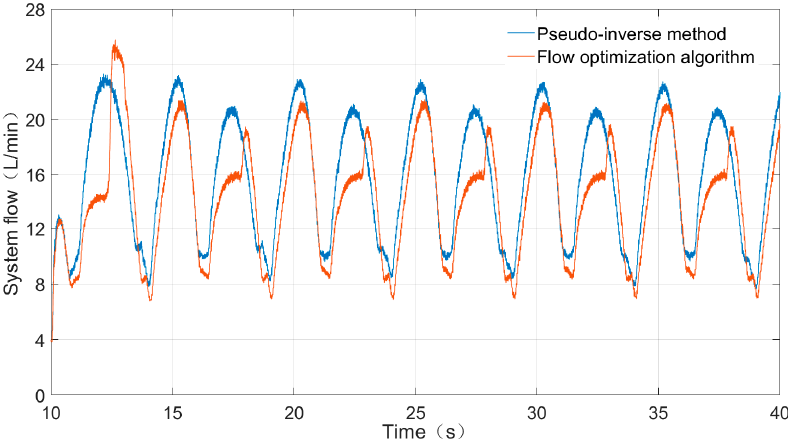
Figure 9. The actual joint velocity according to the pseudo-inverse method and the flow optimization algorithm in the experiments.